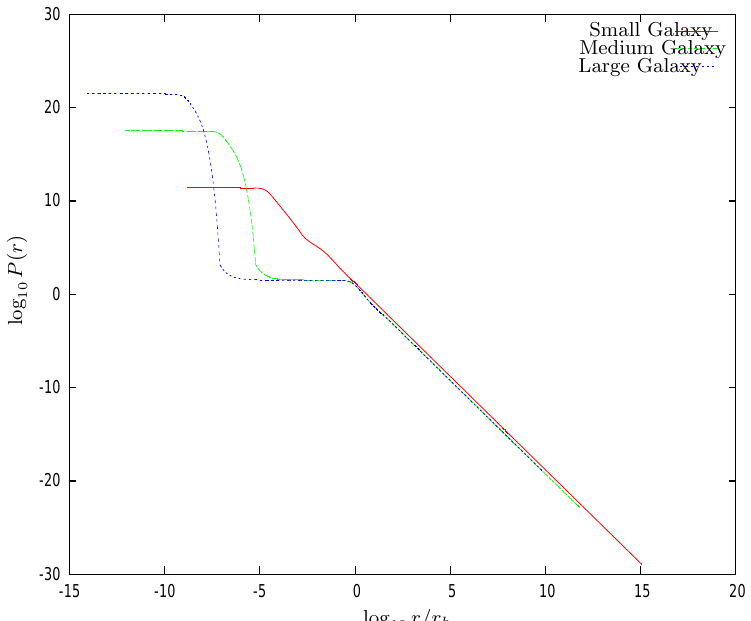
r h vs. the common logarithm of the central black hole mass log 10 4 3 where the constant C ( ξ 0 ) is a decreasing function of ξ 0 . BH